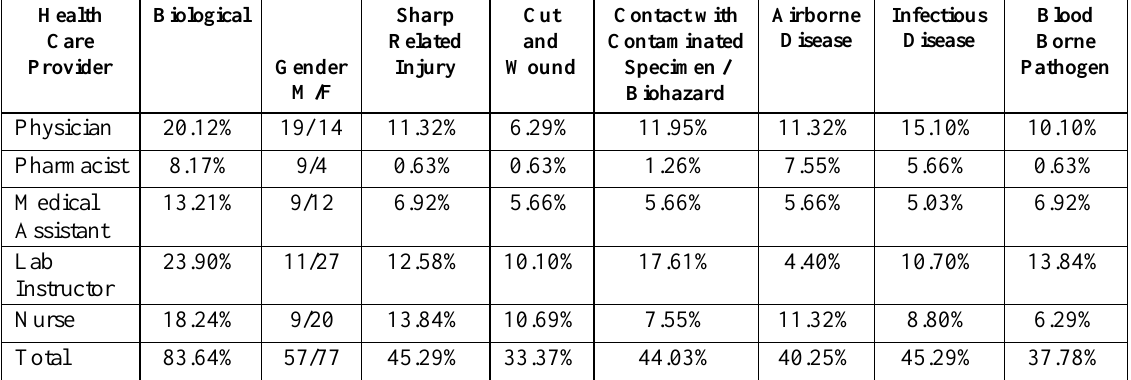
Table 3. Biological hazards in different healthcare providers